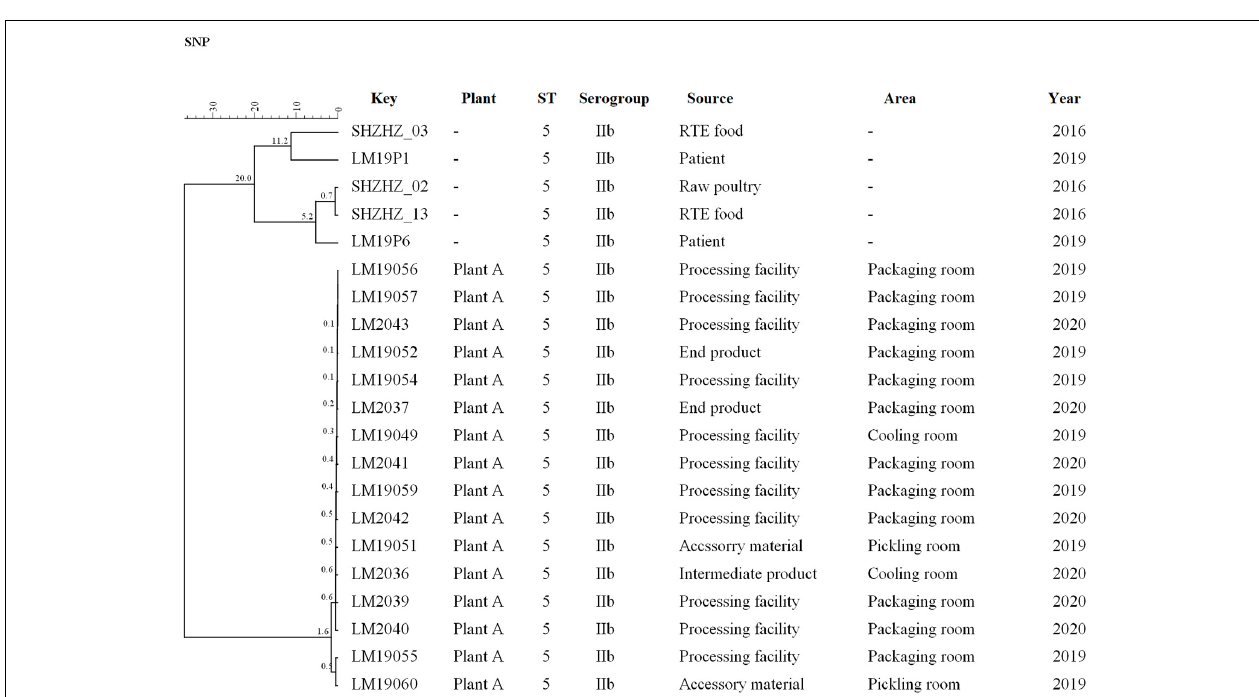
FIGURE 2 | Minimum spanning tree of cgMLST data for the 23 L. monocytogenes isolates. The multiplication by 1 in the tree represents the number of different alleles among isolates. The corresponding data, including the name of the isolates (Key), ST, serogroup, year, source, cluster, area, and accession number, are shown along with the dendrogram to the right.